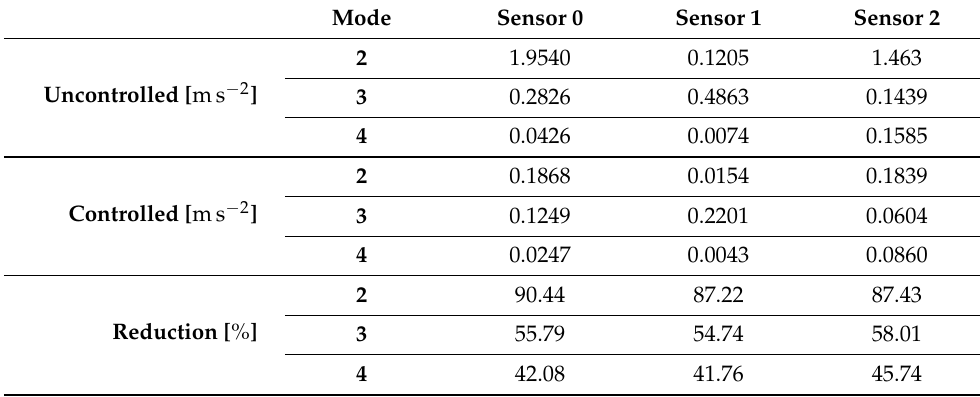
Table 7. Comparison between the vibration of the uncontrolled (blue line) and controlled (red line) system on the three sensors locations in experimental